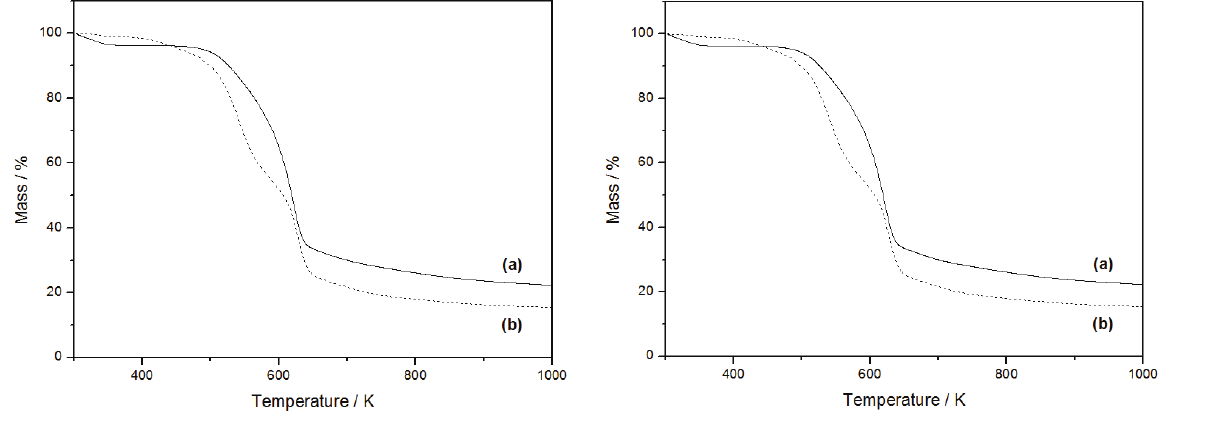
Figure 3 - Thermogravimetric curves for wood sawdust, WS (a) and wood sawdust modified with succinic anhydride, SSA (b) .